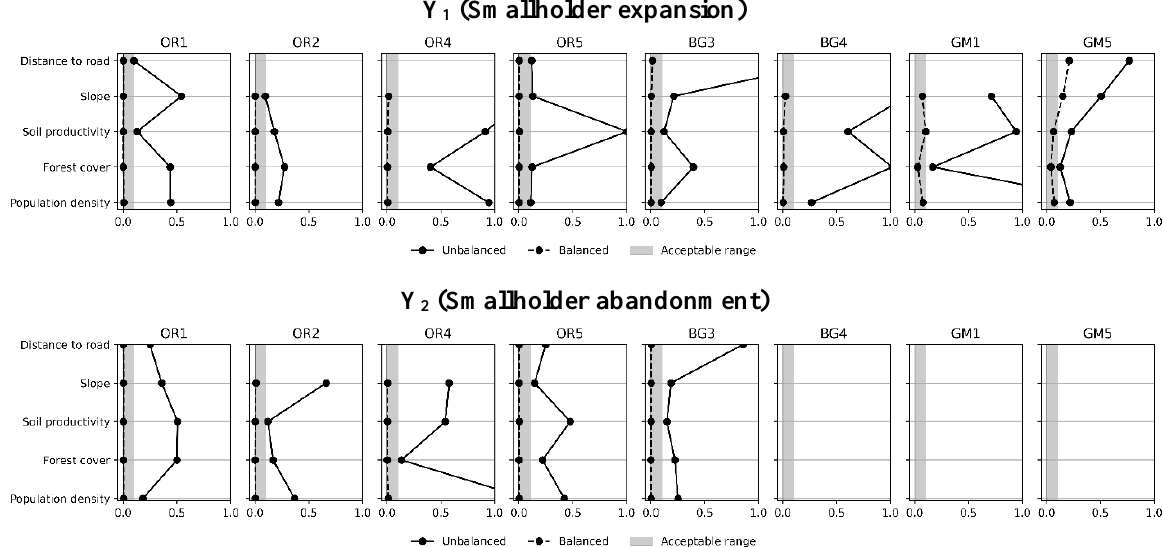
Fig. A4.3: Covariate bias for each covariate used in the second-stage rebalancing. The horizontal axes plot the absolute standardized mean difference (AMSD; Equation 1 in the main manuscript). BG4, GM1, and GM5 were excluded from the smallholder abandonment analysis (Y ). The distance to road covariate 2 was excluded in four sites (BG4, GM1, OR2, and OR4) due to limited overlap in these data between the Treatment and Control sites (Fig. A4.2).